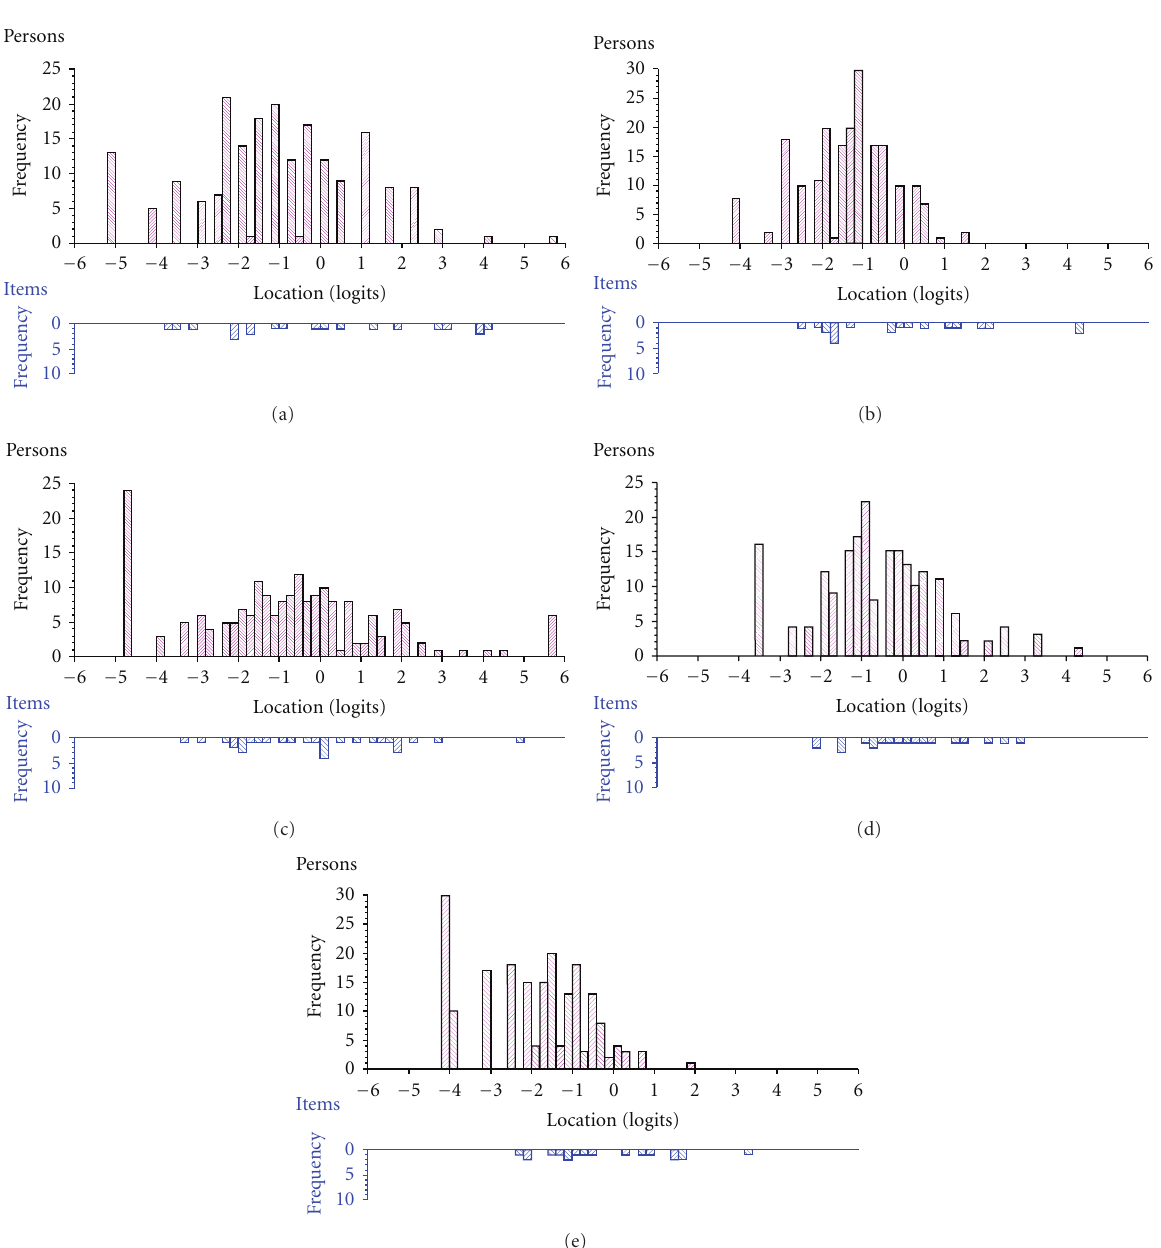
Figure 2: Distributions of the locations of people (upper histogram in each panel) and response category thresholds (lower histogram in each panel) on the common logit metric (positive values = more problems). Response category thresholds are the locations where there is a 50/50 probability of endorsing either of two adjacent categories and represent the quantitative “notches” on the latent ruler defined by a set of items. (a) Item set BFa (items 17, 18, 20–22); (b) Item set BFb (items 30, 32, 33, 37–39); (c) Item set APa (items 1, 2, 4–7, 11, 12); (d) Item set APb (items 13–16, 24); (e) Item set E (items 23, 25, 26, 28, 29, 36). Mean (SD) person locations are BFa (panel (a)), − 1 . 115 (1.951); BFb (panel (b)), − 1 . 363 (1.096); APa (panel (c)), − 0 . 814 (2.326); APb (panel (d)), − 0 . 671 (1.370); E (panel (e)), − 1 . 967